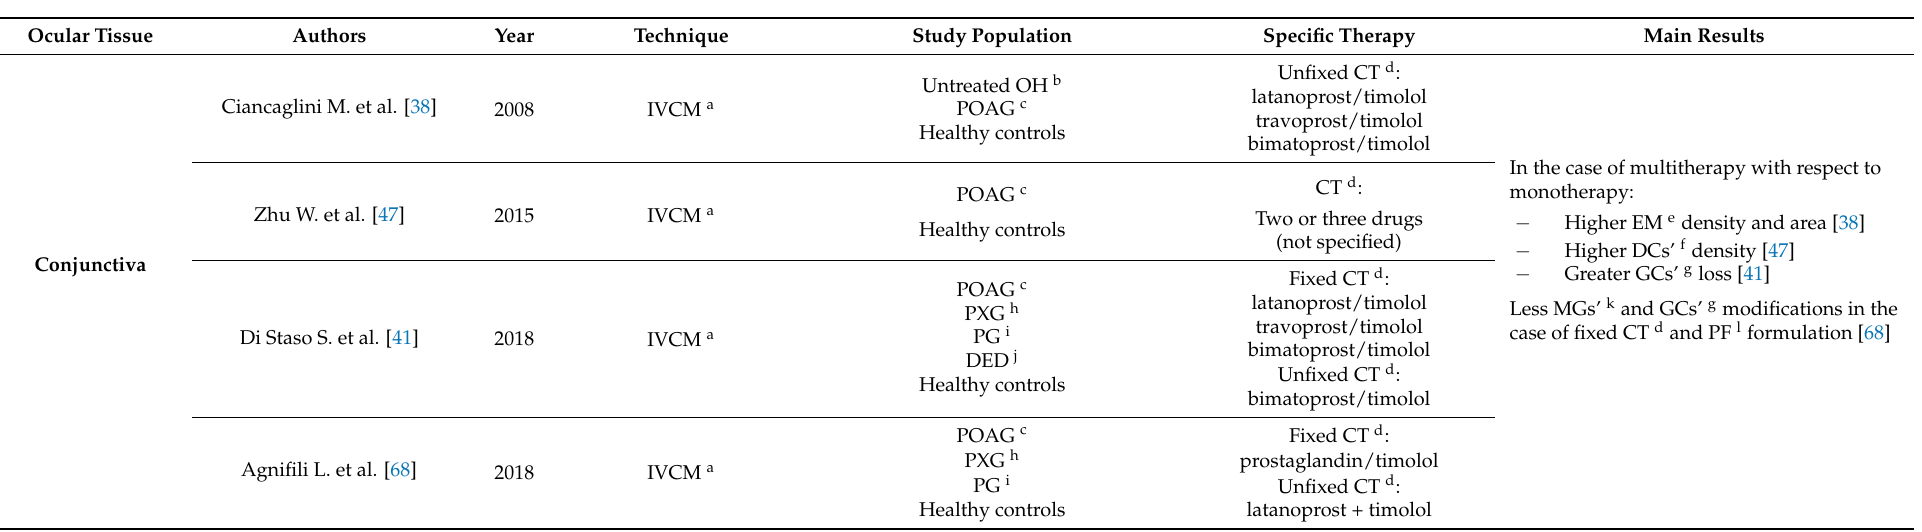
Table 2. Summary of clinical studies evaluating the main morphological changes induced by combined therapy on the ocular surface using IVCM and